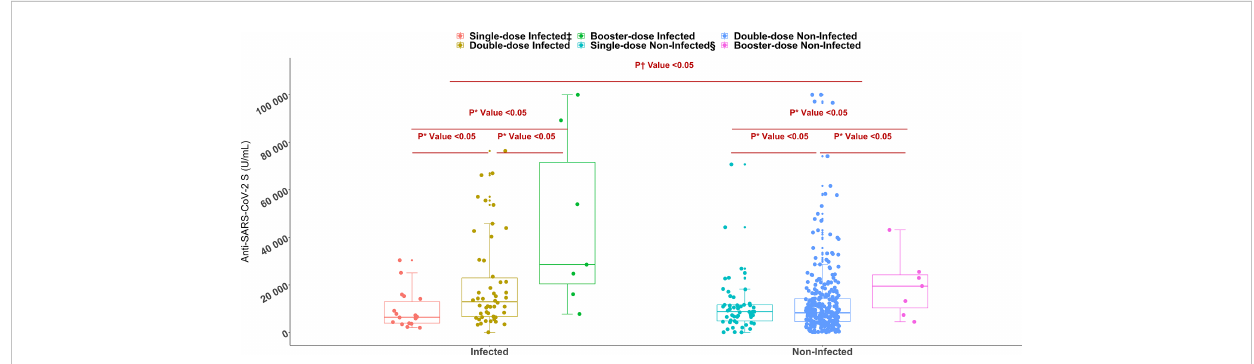
FIGURE 3 Anti-SARS-CoV-2 S antibody titers among single, double, and booster dose recipients of SARS-CoV-2 S antigen targeted vaccines (n= 447, Moderna/Spikevax, P fi zer/Comirnaty, AstraZeneca/Covishield). *P value is generated by Poisson regression model and the model was adjusted for age, vaccine types, and time since last vaccination. † P value is generated by Mann Whitney U test. ‡ Infected = workers infected with SARS-CoV-2, § Non-Infected = workers who didn ’ t infect with